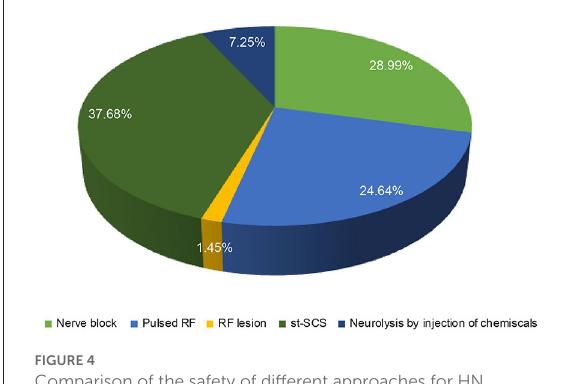
FIGURE4 Comparison of the safety of different approaches for HN treatment. More physicians (26/76, 37.68%) choose st-SCS as the safety procedure, decrease by degree, nerve block (20/76, 28.99%), nerve pulsed radiofrequency (17/76, 24.64%), neurolysis with an injection of chemicals (5/76, 7.25%) and nerve radiofrequency lesion (1/76, 1.45%).